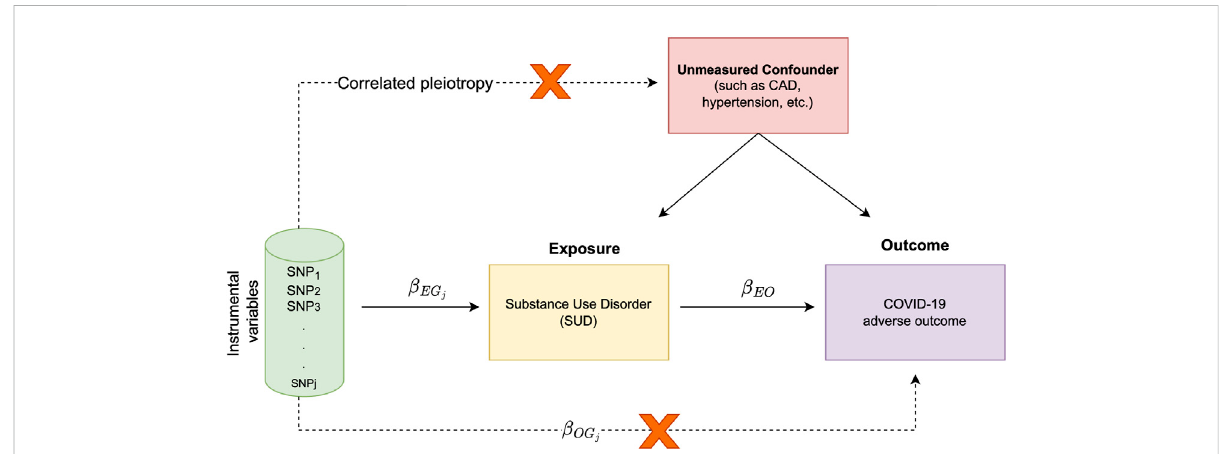
FIGURE 1 Schematic representation of study overview and assumptions underlying MR analysis; The target of inference in MR analysis is β EO (i.e., the causal effect of the exposure trait on the outcome). In this causal diagram, β EG is the measure of association between the genetic variant G j and the j is the association of G j with the outcome (i.e., COVID-19 hospitalization or severe respiratory symptom) exposure trait (i.e., SUD in our analysis), β OG j and β EO is the causal effect of exposure trait on the outcome. In our analysis, we make two important assumptions; 1) we assume that